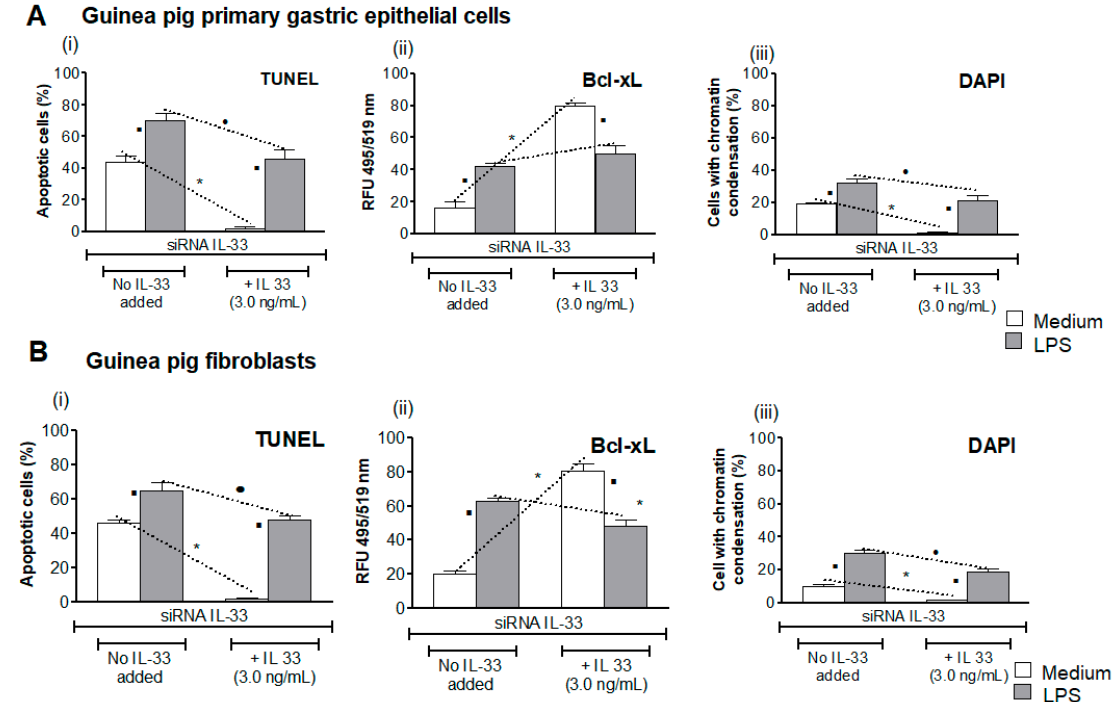
Figure 4. Assessment of apoptosis. Cell apoptosis was estimated by terminal deoxynucleotidyl transferase (TdT)-mediated dUTP nick end labeling (TUNEL) assay ( i ), assessment of expression of anti-apoptotic Bcl-xL protein by using anti-Bcl-xL primary antibodies and secondary antibodies conjugated with isothiocyanate fluorescein (FITC) ( ii ), and 4 (cid:48) ,6-diamino-2-phenylindole (DAPI) nuclear staining ( iii ). The results for the guinea pig primary gastric epithelial cells ( A ) or fibroblasts ( B ), transfected with siRNA IL-33, which were not treated or treated with H. pylori lipopolysaccharide (LPS), 25 ng/mL, in the culture medium without or with IL-33 (3.0 ng/mL), are presented. The cell fluorescence was measured using a fluorescence reader (Victor2, Wallac, Oy Turku, Finland) at appropriate wavelengths: 495 excitation and 519 emission for FITC, 550 nm excitation and 590 nm emission for TUNEL, and 345 nm excitation and 455 nm emission for DAPI. Results are shown as median with the range of five experiments performed in triplicate for each experimental variant. Statistical analysis was performed using the nonparametric Mann-Whitney U test with significance at p < 0.05. *cells in medium without IL-33 vs. cells in medium with IL-33, not treated with LPS H. pylori ; • cells treated with LPS H. pylori , in medium without IL-33 vs. cells treated with LPS in medium with IL-33; (cid:110) cells not treated with LPS H. pylori vs. cells treated with LPS H. pylori , in medium without or with